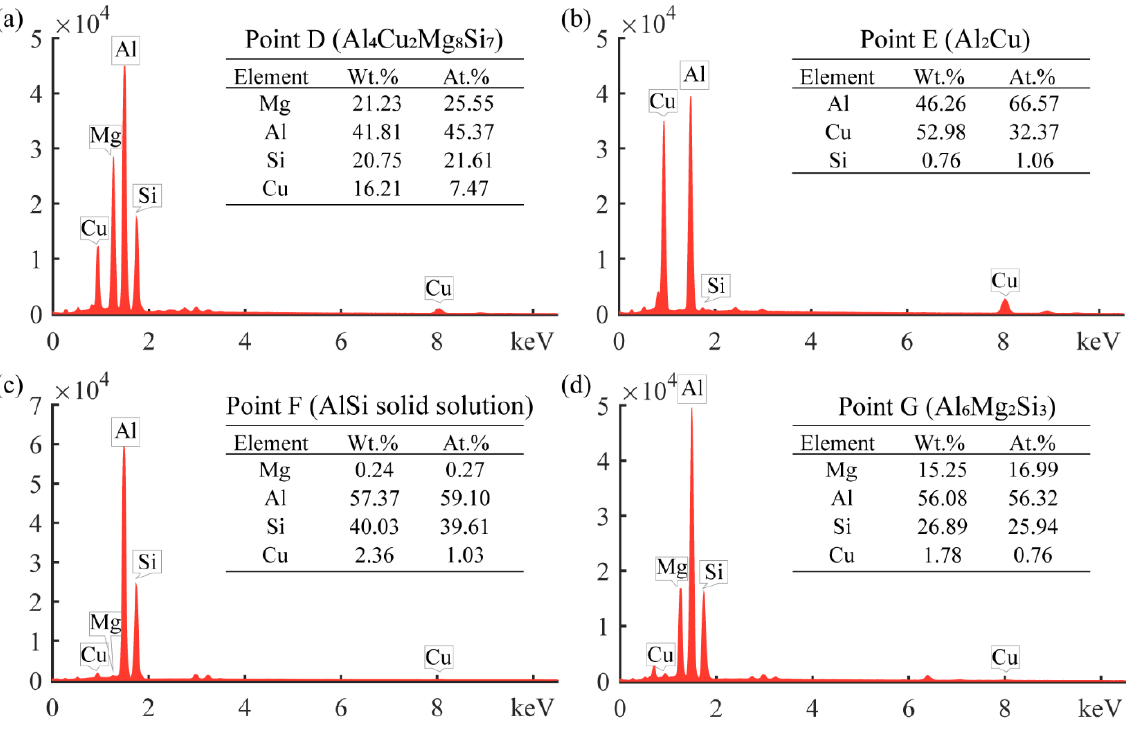
Figure 9. EDS results of the metallurgical composite layer: ( a ) point D, ( b ) point E, ( c ) point F, ( d ) point G.